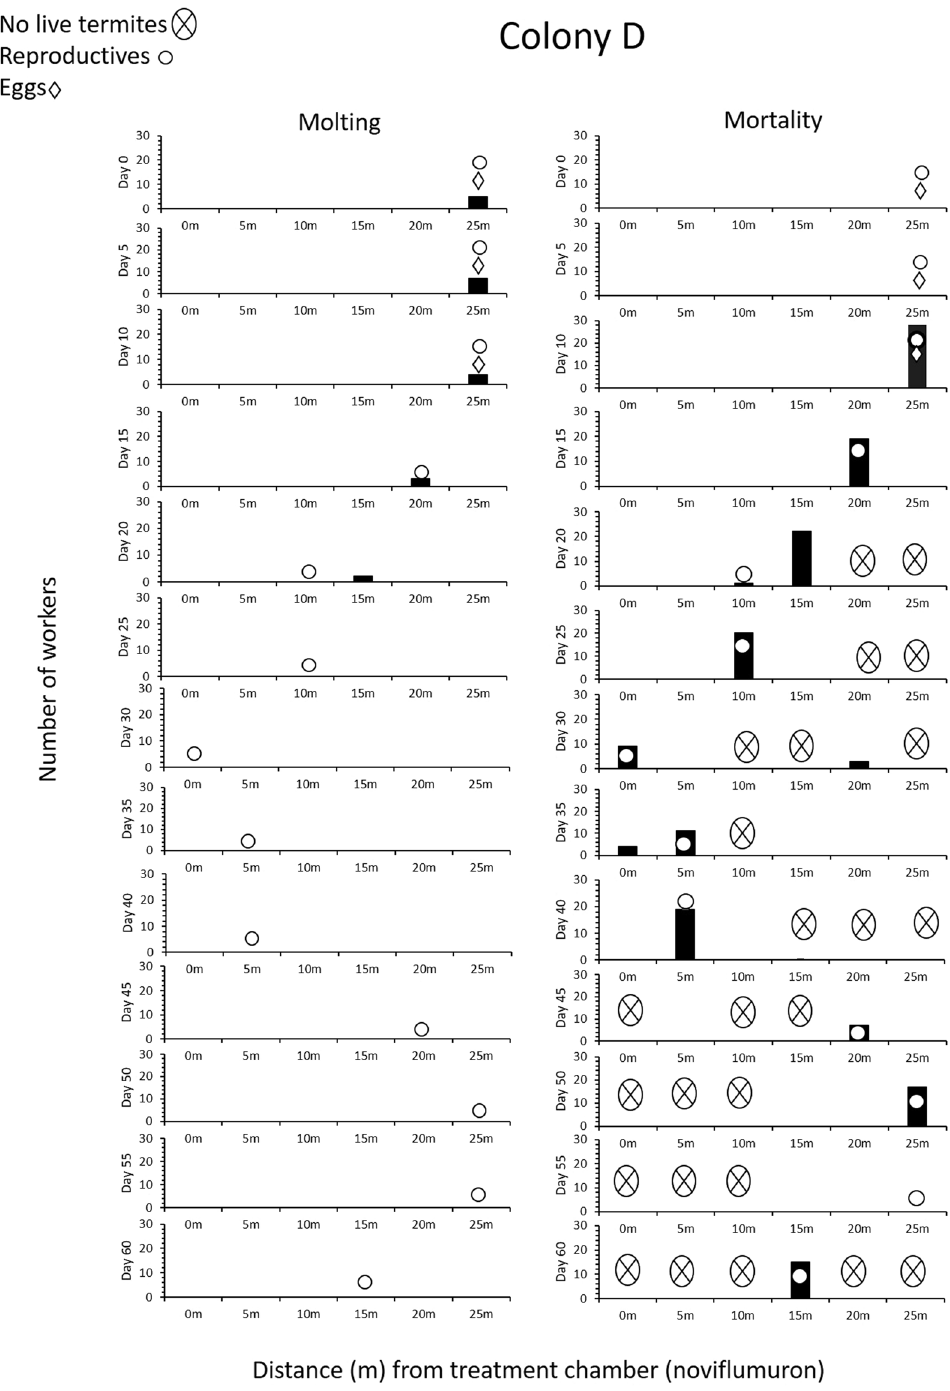
Figure 2. Number of worker molting (left) and worker mortality (right) in a 6 yr old juvenile colony (D) for noviflumuron